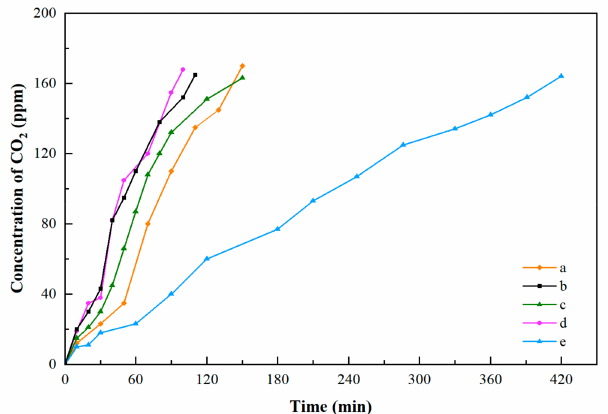
Figure 5. Breakthrough curves of blank 13X and modified 13X were compared at 20 ◦ C: (a) blank 13X, (b) ZnCl 2 -13X, (c) ZnAc 2 -13X, (d) ZnSO 4 -13X and (e) Zn(NO 3 ) 2 -13X, respectively.